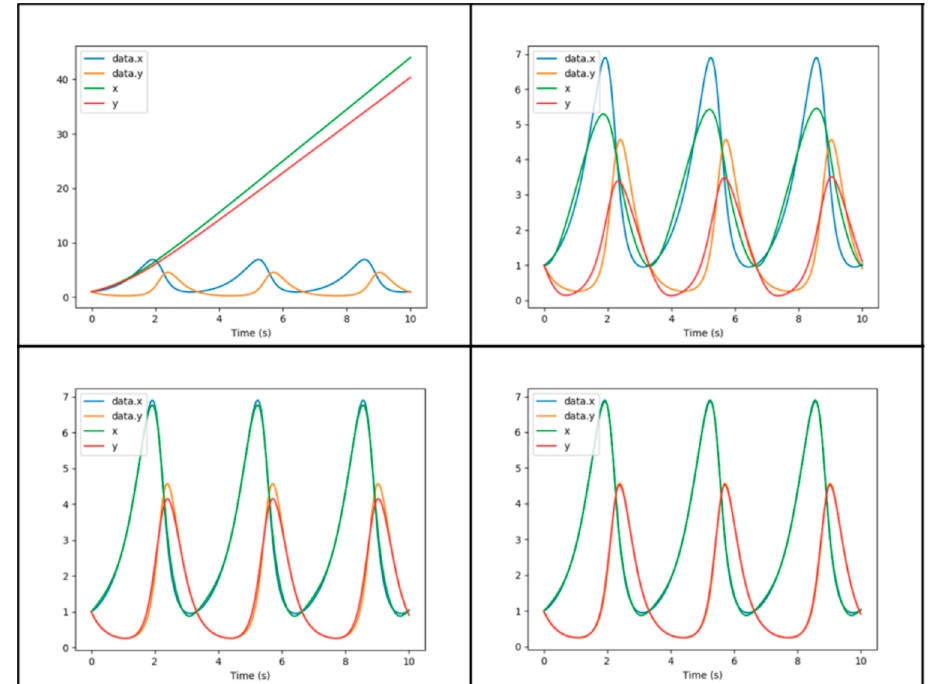
Figure A3. Progress of OPLES in training the neural ordinary di ff erential equation (ODE) system: Blue and orange represent the true ODE system, while green and red represent the behavior of the optimized neural ODE system.